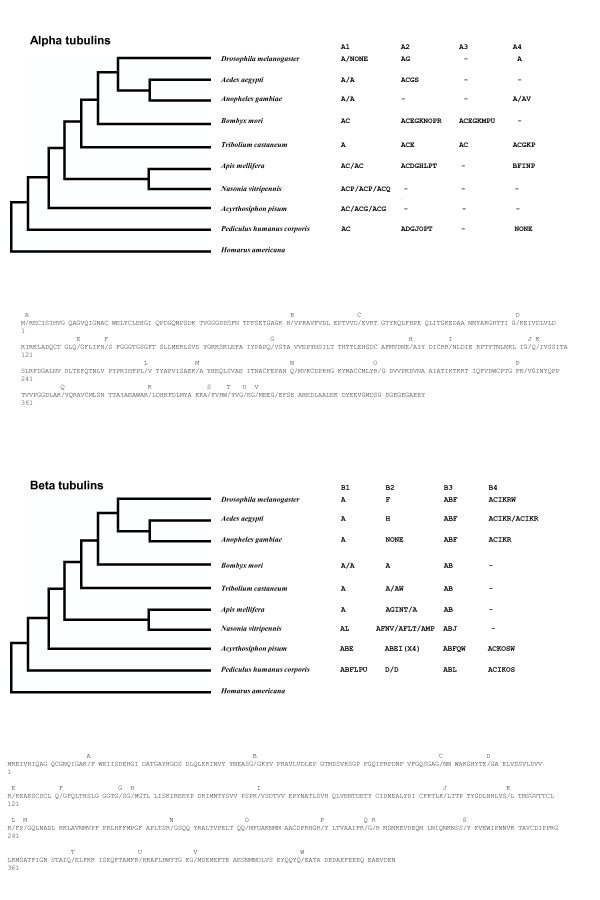
Beta and alpha tubulin introns. Beta and alpha tubulin introns are plotted on an insect phylogeny [19], and on Dmα1 and Dmβ1 protein sequences. Introns are labeled A-W and A-V, from the most 5' to most 3' intron found in beta and alpha tubulins. Introns for taxa with multiple copies of an isoform are presented in order, ie. Nvα1a/Nvα1b/Nvα1c.